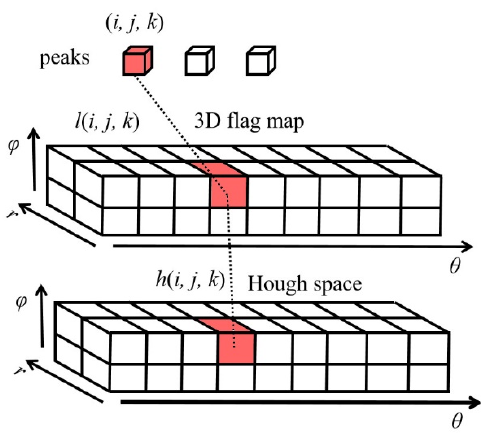
Figure 4. Peaks searched from a 3D flag map.